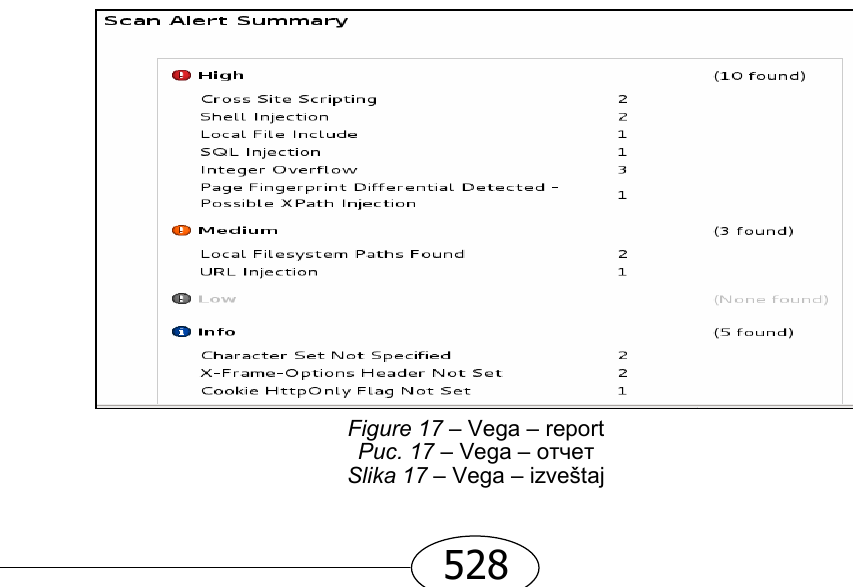
Figure 17 – Vega – report Рис . 17 – Vega –